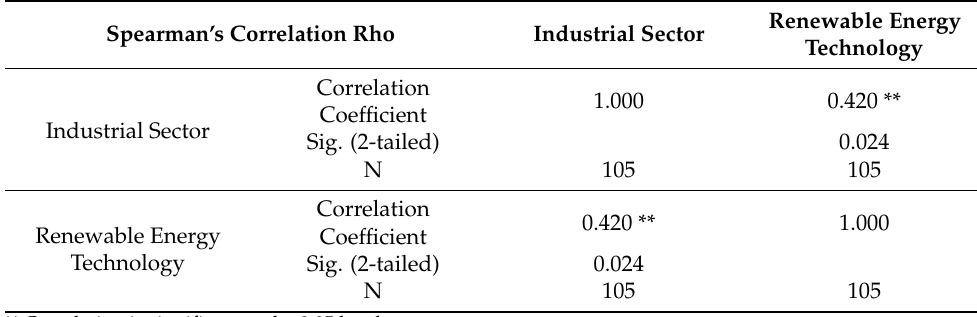
Table 7. Evaluation of the null and alternative research hypotheses.